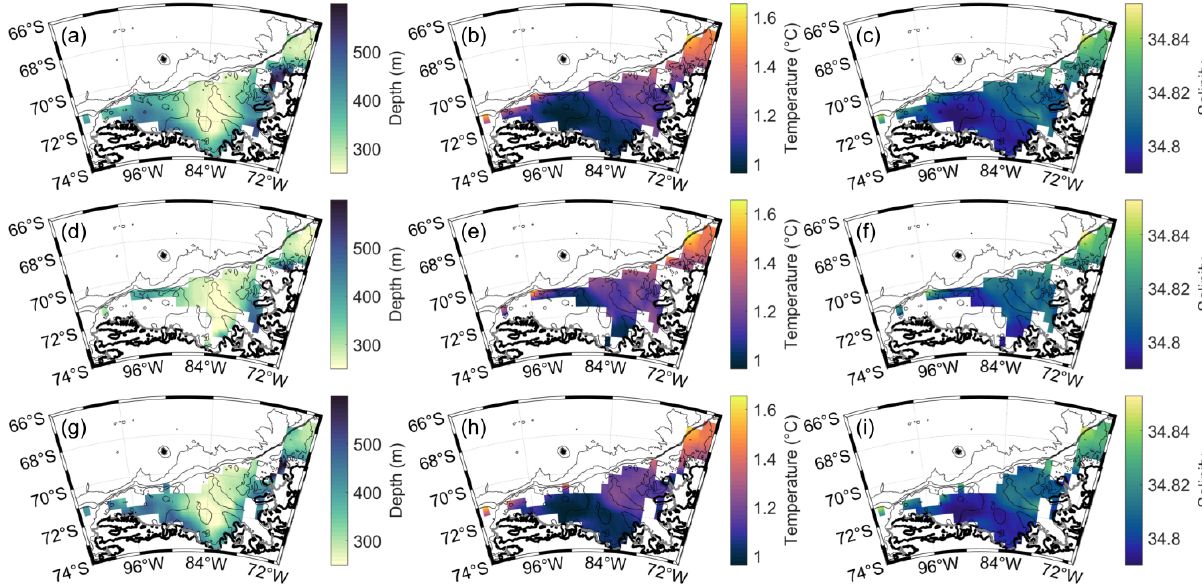
Figure A4. The distribution of properties on the CDW potential density layer ( σ 0 = 27 . 75kgm − 3 ), divided into (a–c) median, (d–f) winter (April–September), and (g–i) summer (October–March) months. (a, d, g) Depth of the density layer (meters), (b, e, h) potential temperature (degrees Celsius), and (c, f, i) salinity are